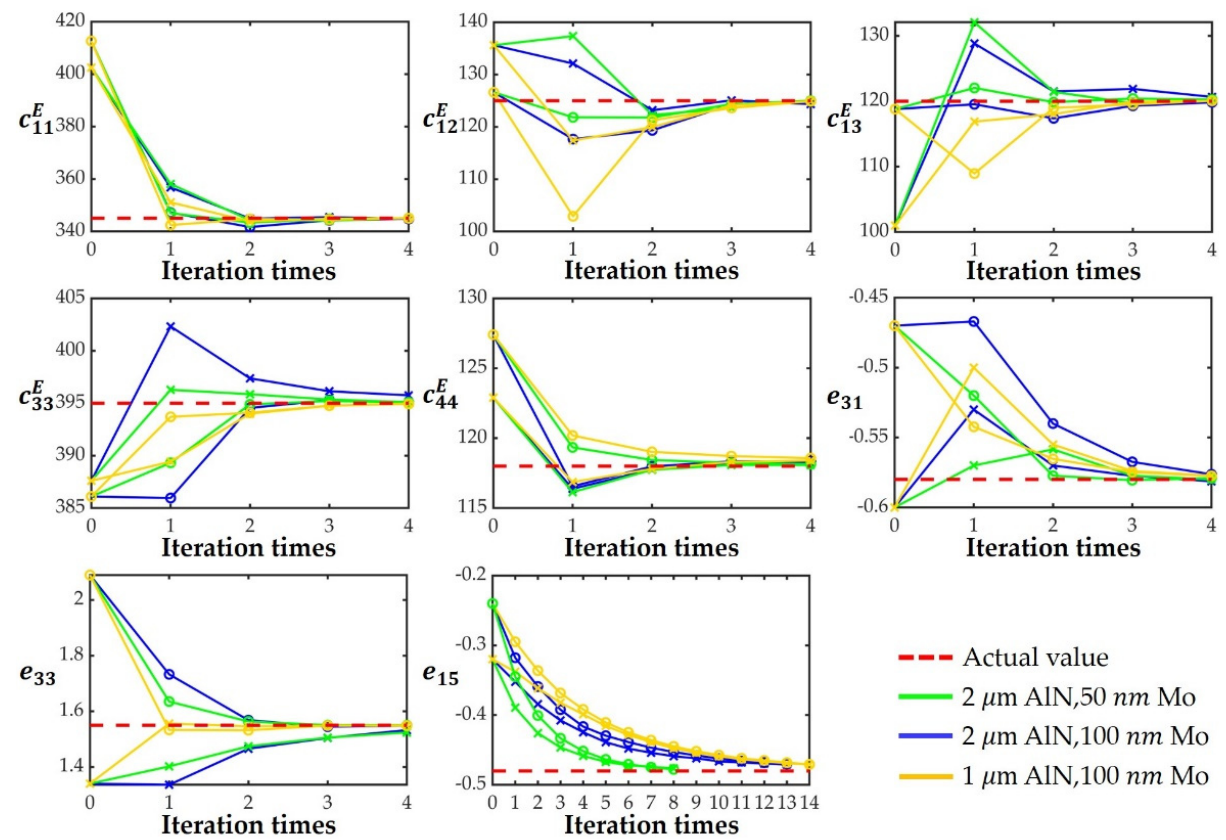
Figure 6. The extracted material coefficients for different iteration times, where the zeroth iterations are the initial coefficients. The circles and crosses represent the use of initial coefficient 1 and initial coefficient 2, respectively. Table 2. The assumed actual material coefficients of the AlN thin film [15] used in the simulated iteration processes and the final extraction results in different cases.